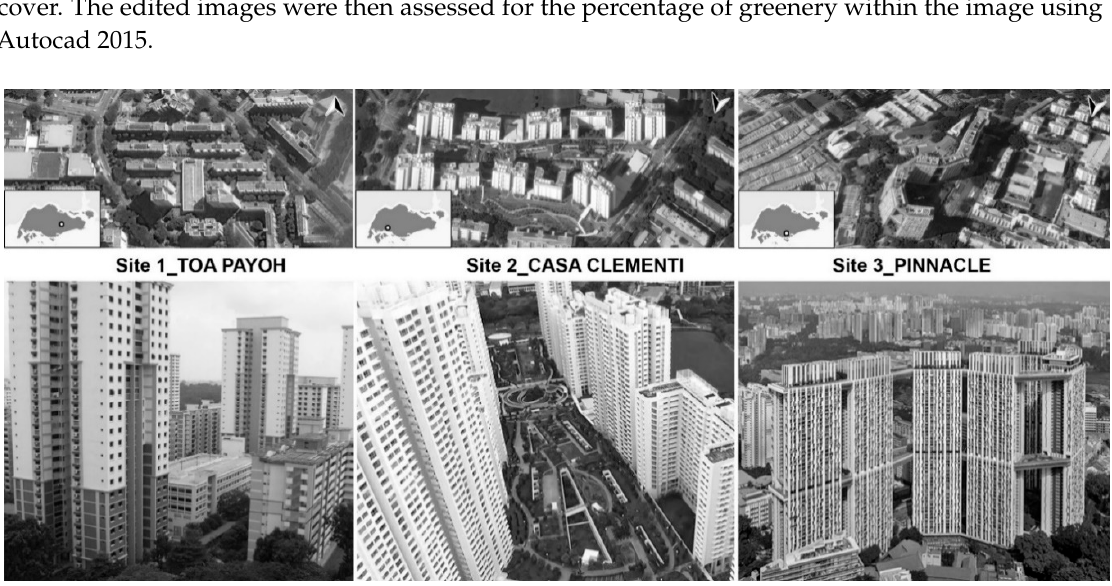
Figure 1 . Location of three chosen sites for photo-stimuli around Singapore. Figure 1. Location of three chosen sites for photo-stimuli around